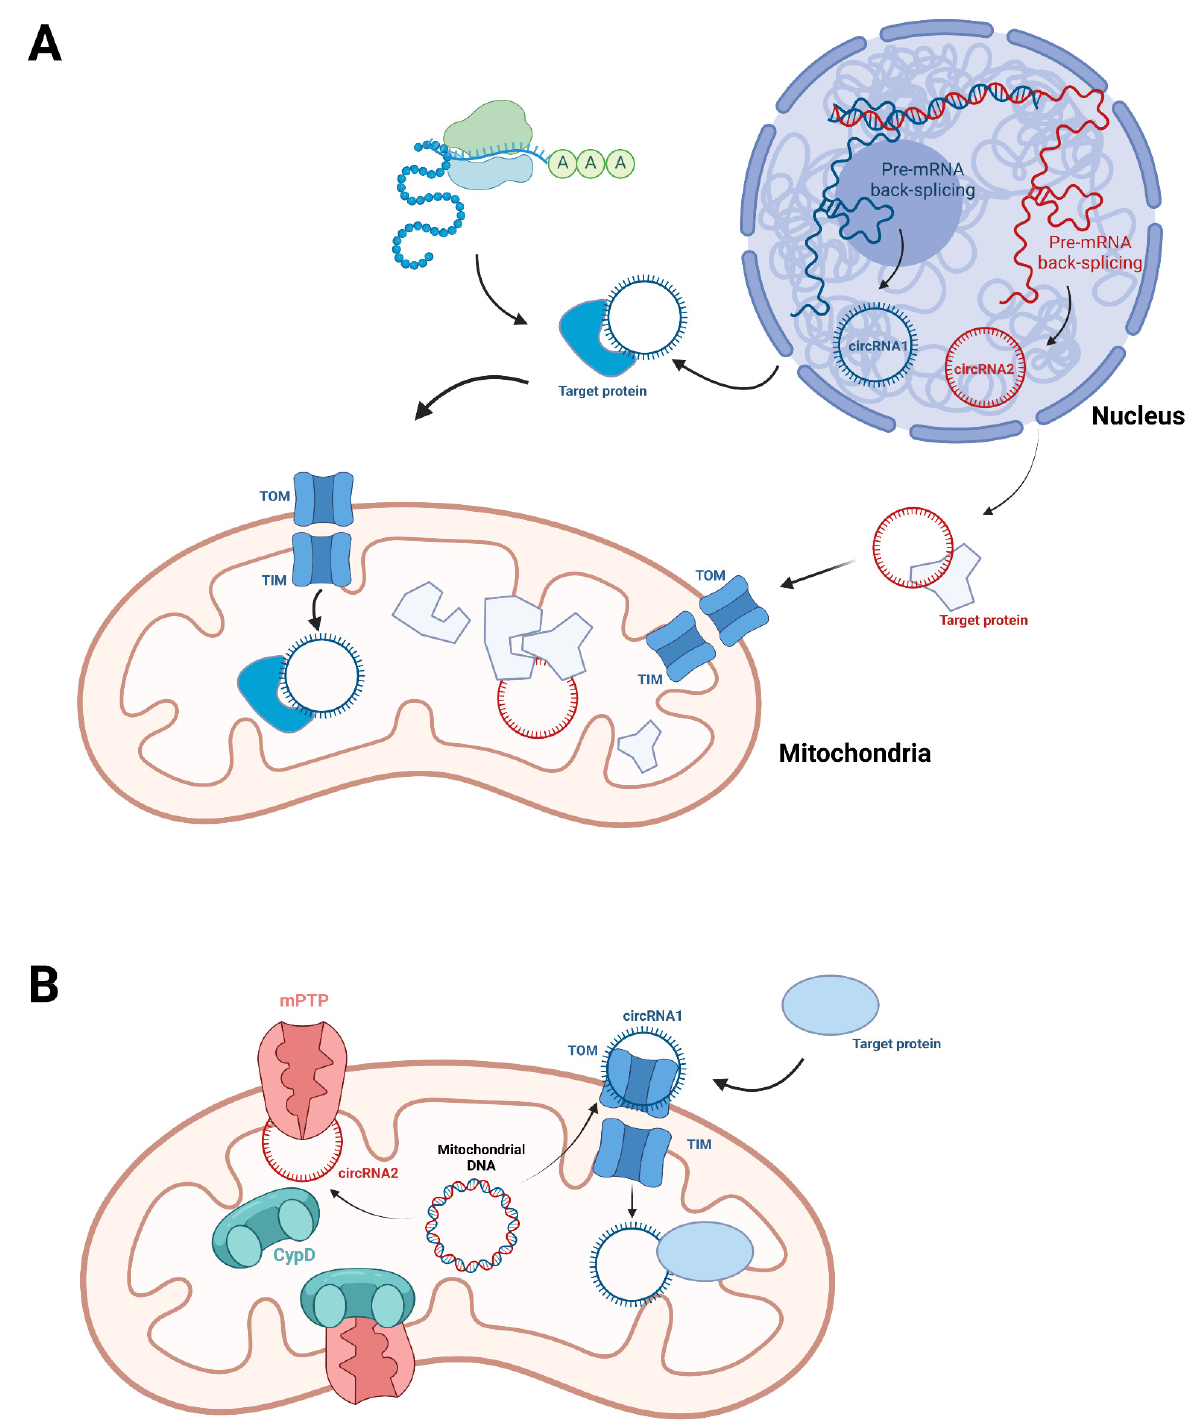
Figure 3. The biogenesis, translocation and function of nuclear genome-encoded mitochondrial circRNAs ( A ) and mitochondrial genome-encoded circRNAs. ( A ) Nuclear genome-encoded mitochondrial circRNAs are generated from back-splicing of pre-mRNA. Their mitochondrial localization might be related to their associated mitochondrial proteins. In mitochondria, these circRNAs interact with proteins to affect their translocation. They also act as protein scaffolds. ( B ) The detailed mechanism of mitochondrial genome-encoded circRNAs biogenesis has not been clear. The mitochondrial genome-encoded circRNAs can interact with proteins to affect their association. For instance, the interaction between CypD and mPTP subunits can be modulated by circRNA. The circRNAs are also found to be co-localized with mitochondrial transport machineries, such as TOM40, to facilitate protein